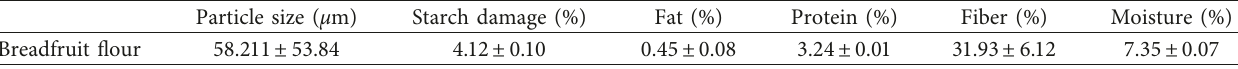
Table 1: Mean values for quality-impacting characteristics of milled experimental breadfruit flour.